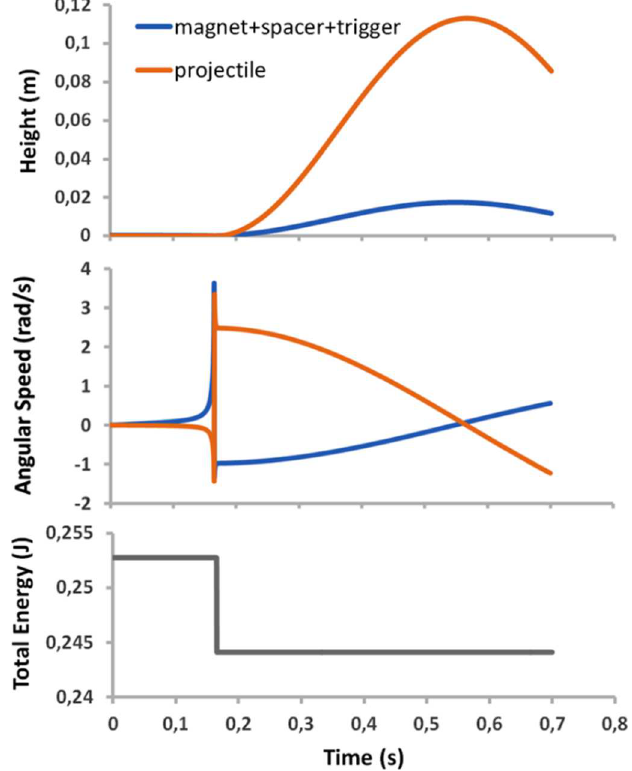
Fig. 12. Scilab simulations for height, angular velocity (for each part of the pendulum identified in the caption) and total energy as a function of time for the case of the 2 mm